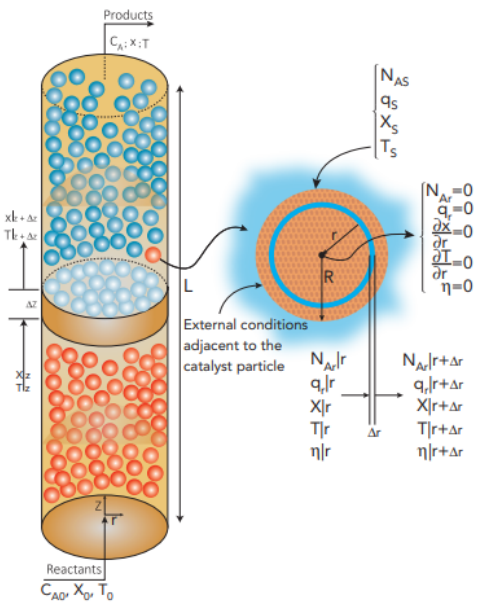
Figure 11. Diagram of the catalytic dehydrogenation process of cyclohexanol [13]. Material and energy balances are established for a cylindrical geometry fixed-bed reactor considering the two-dimensional model with radial diffusion, according to Garc í a- Ochoa et al. [10]. The mass balance equation (subscript A = cyclohexanol, B = cyclohexanone, and C = hydrogen) in terms of concentration and temperature is given